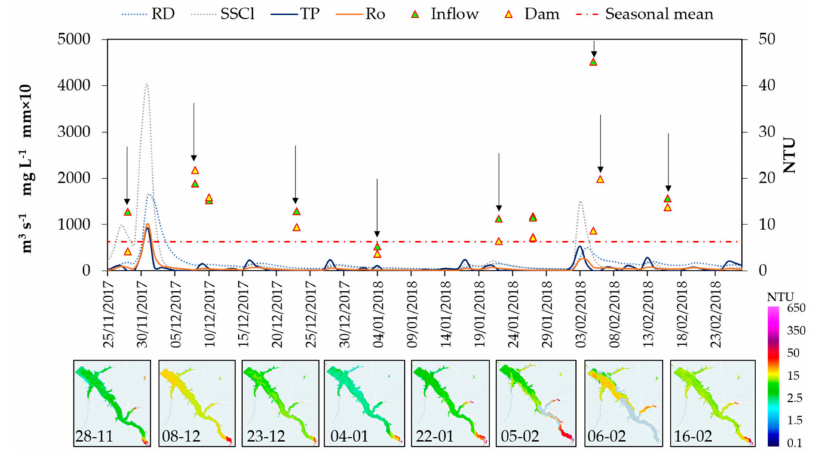
Figure 6. Timeseries of RD, SSCl, TP, and Ro, with mean Turb values at inflow (green triangles) and dam (yellow triangles) virtual stations. Black arrows indicate the dates for which the relative Turb map is shown. The red dotted line represents the Turb autumn–winter seasonal mean averaged over the 5-year period. Note that TP and Ro are expressed in mm × 10 to have a better representation.